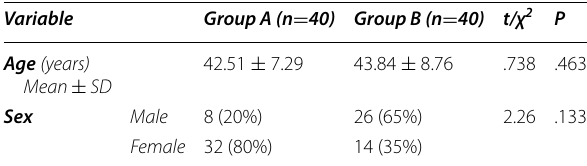
Table 1 Demographic data of the two studied groups Variable